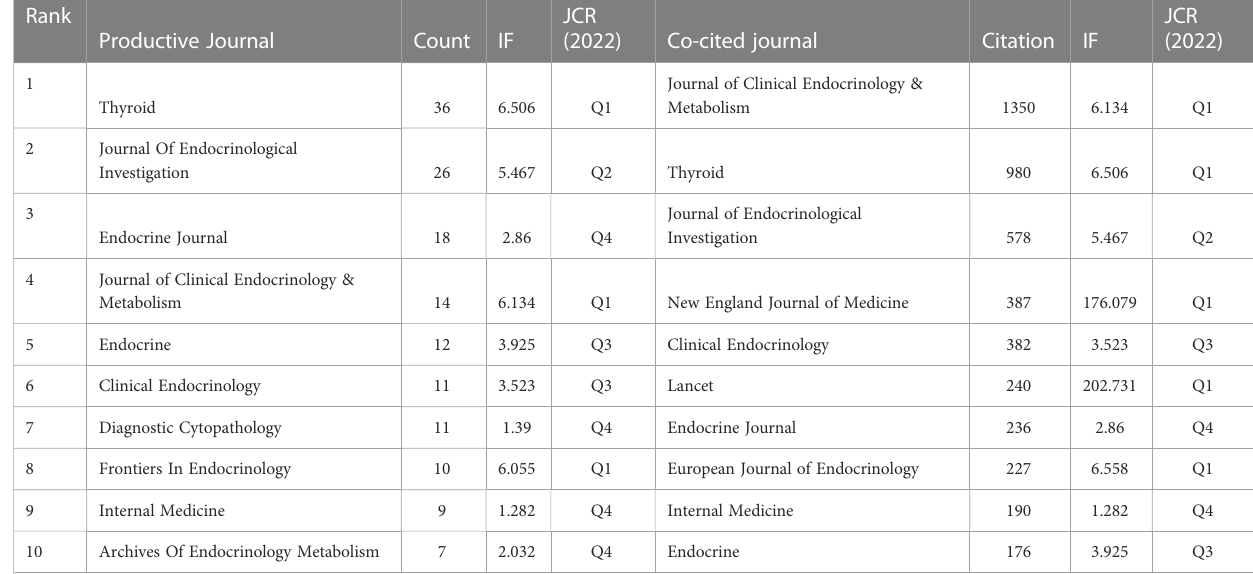
TABLE 1 Top 10 productive journals and co-cited journals of SAT research.